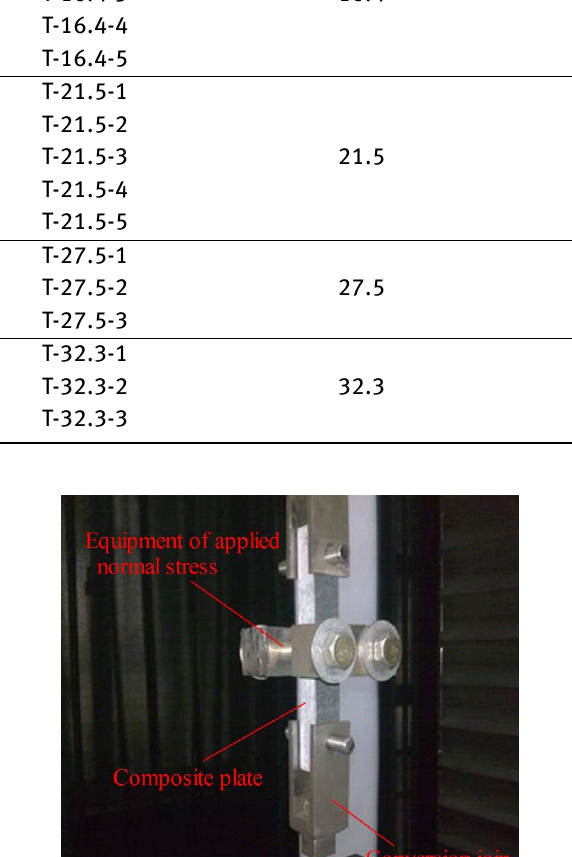
Figure 6: Specimen loading